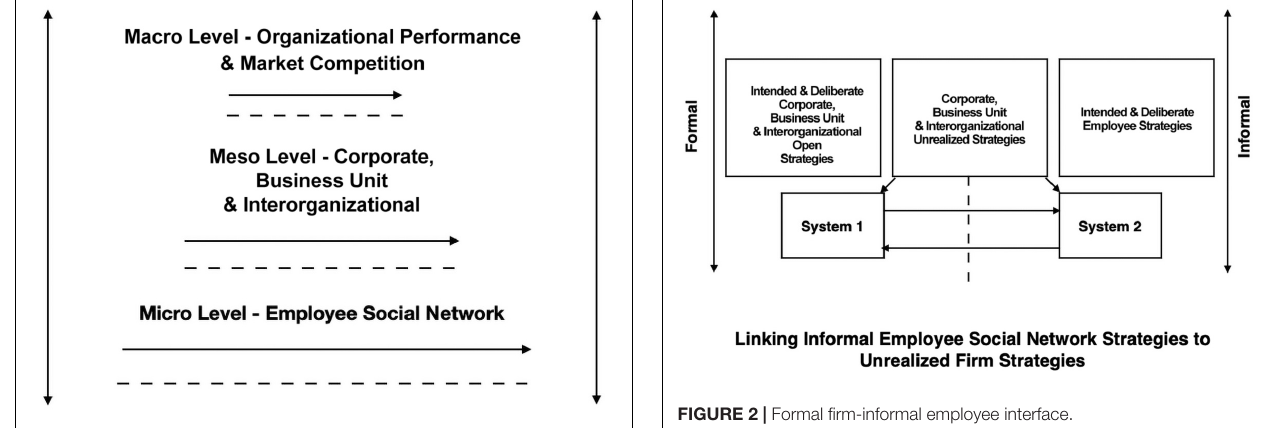
FIGURE 2 | Formal firm-informal employee